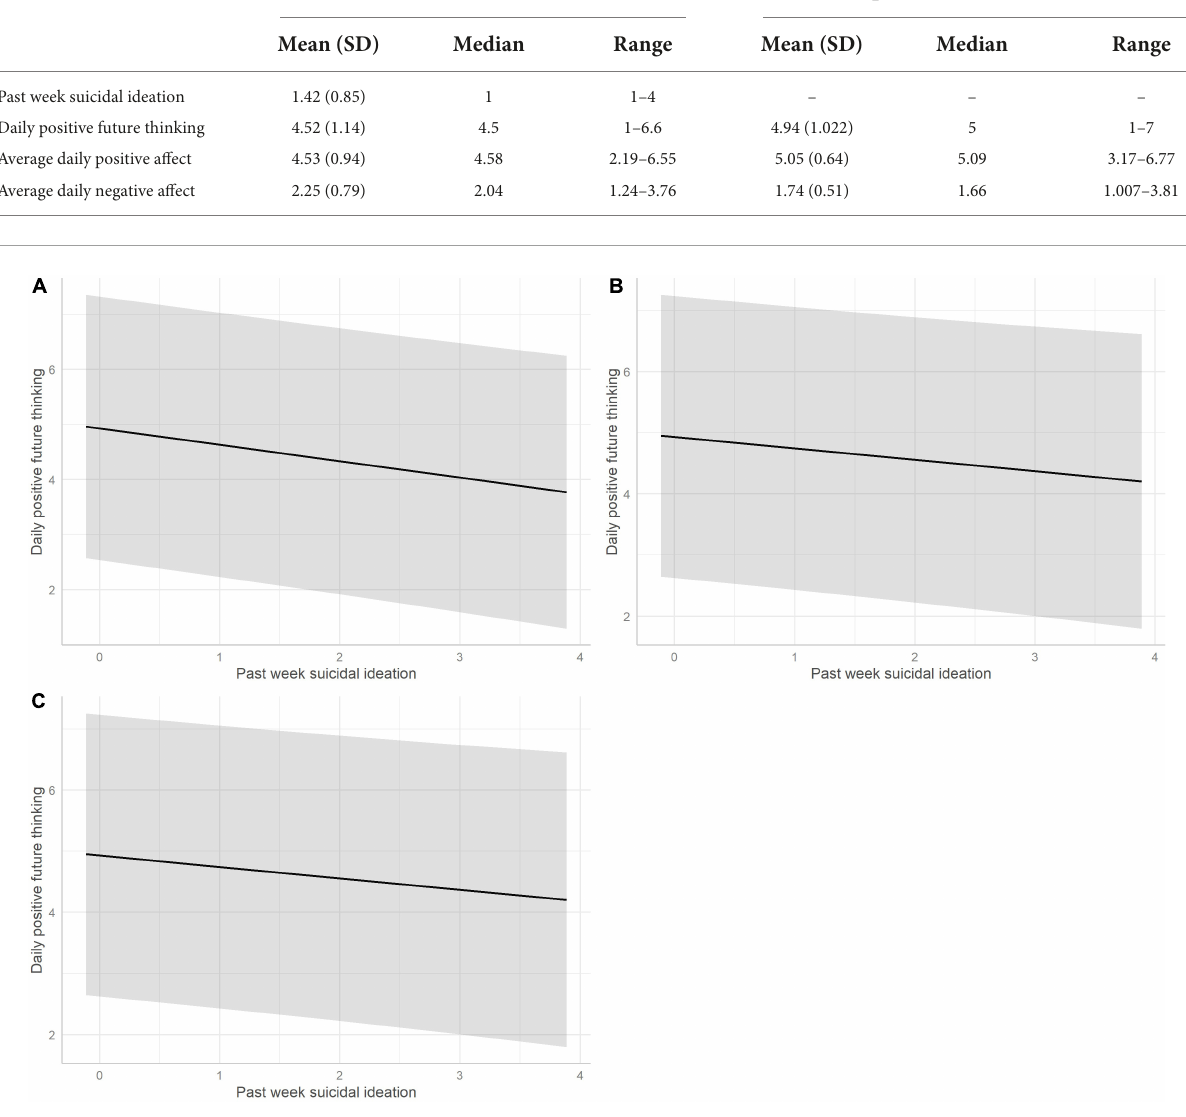
FIGURE1 The association between daily positive future thinking and past-week suicidal ideation, controlling for (A) age and sex; (B) age, sex, and average positive affect from the previous day; and (C) age, sex, and average negative affect from the previous day. Shading represents 95% confidence